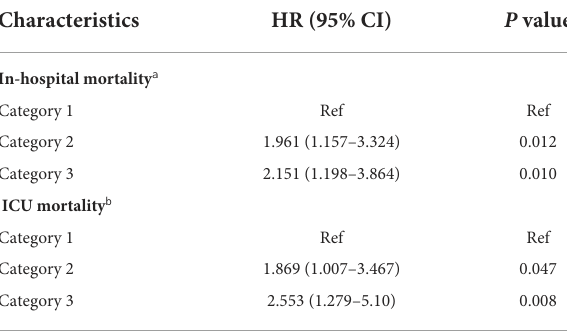
TABLE 3 Multivariate Cox analysis for in-hospital and ICU mortalities across anion gap groups. Characteristics HR (95% CI) P